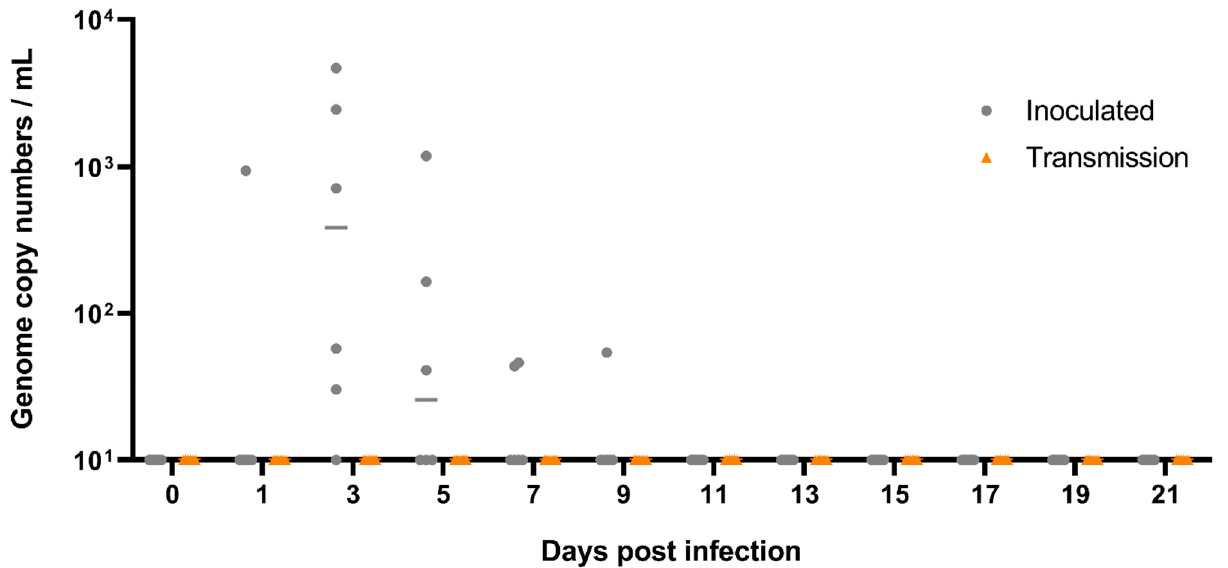
Figure 4. Viral shedding from oral swabs of the Rousettus bats following A/bat/Egypt/381OP/2017 (H9N2) infection. Viral shedding was monitored by RT-qPCR from swabs taken from the oral cavity. Swabs of six inoculated animals (grey dots) and six contact animals (orange triangles) were taken individually every other day. Samples below 10 viral genome copy numbers per mL (equivalent to Ct 39.2) were considered negative. DPI = Days post infection.